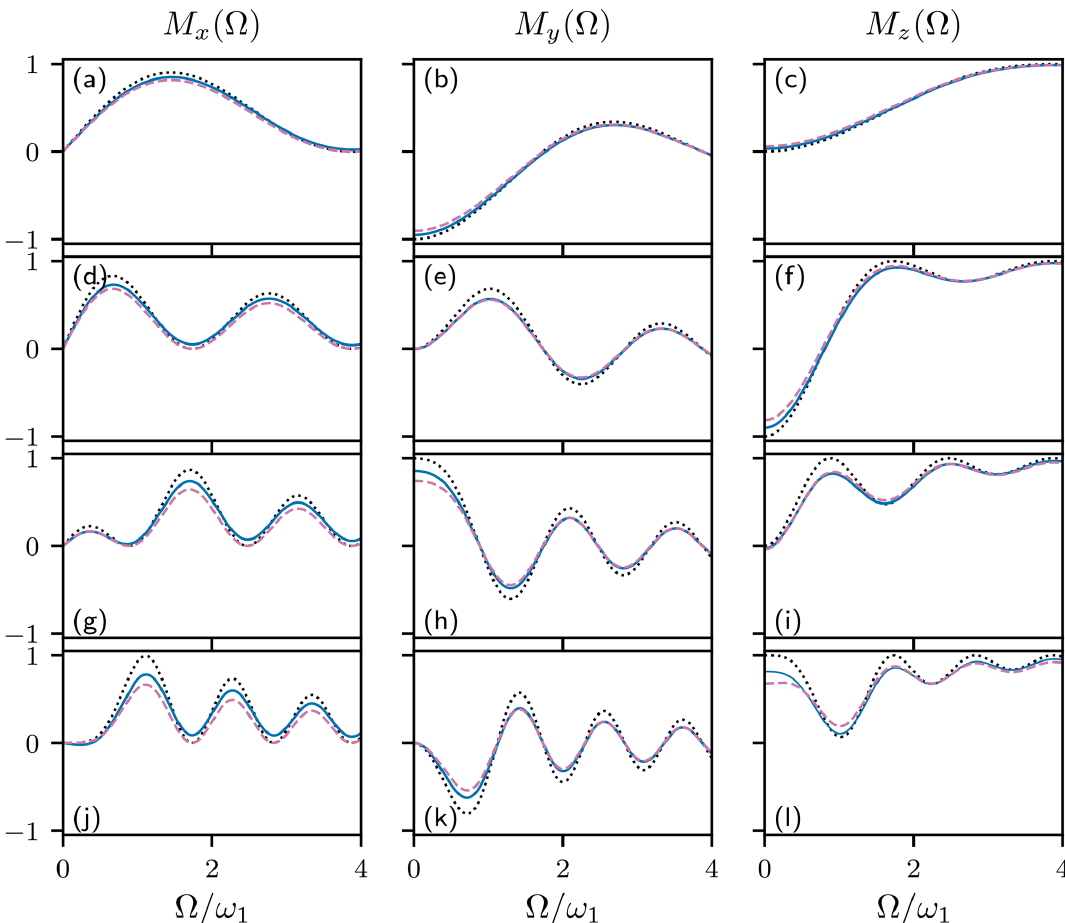
Figure 5. HAM approximations for rectangular (a, b, c) 90 ◦ , (d, e, f) 180 ◦ , (g, h, i) 270 ◦ , and (j, k, l) 360 ◦ pulses applied to initial z magnetization. Values of (a, d, g, j) M x ( (cid:127) ), (b, e, h, k) M y ( (cid:127) ), and (c, f, i, l) M z ( (cid:127) ) are shown as functions of resonance offset (cid:127) . Magnetization components in the absence of exchange, using Eq. (68) (black dotted line), first-order HAM approximation of the Bloch equations using Eq. (69) (reddish-purple dashed line), and exact HAM solution of the Bloch equations using Eq. (70) (blue solid